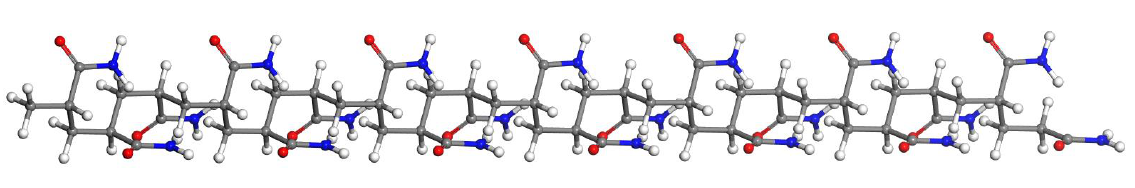
Figure 5—Non-ionic PAM with 20 repeated